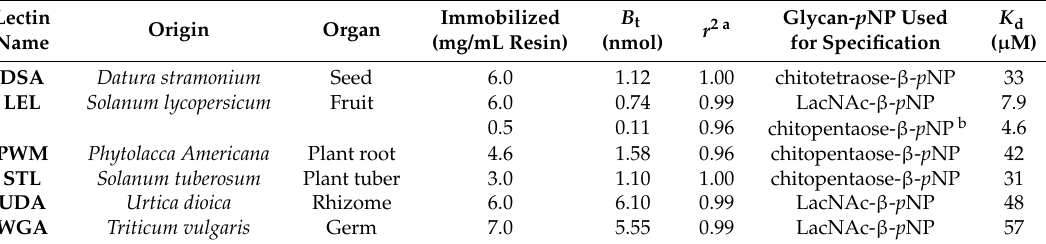
(Table 1). From these data, K d values were derived to be 33 µ M for DSA and chitotetraose- β - p NP, 7.9 µ M for LEL and LacNAc- β - p NP, 4.6 µ M for LEL and chitopentaose- β - p NP, 42 µ M for PWM and chitopentaose- β - p NP, 31 µ M for STL and chitopentaose- β - p NP, 48 µ M for UDA and LacNAc- β - p NP and 57 µ M for WGA and LacNAc- β - p NP (Figure 2). Table 1. Specifications of lectin columns used for FAC analysis.